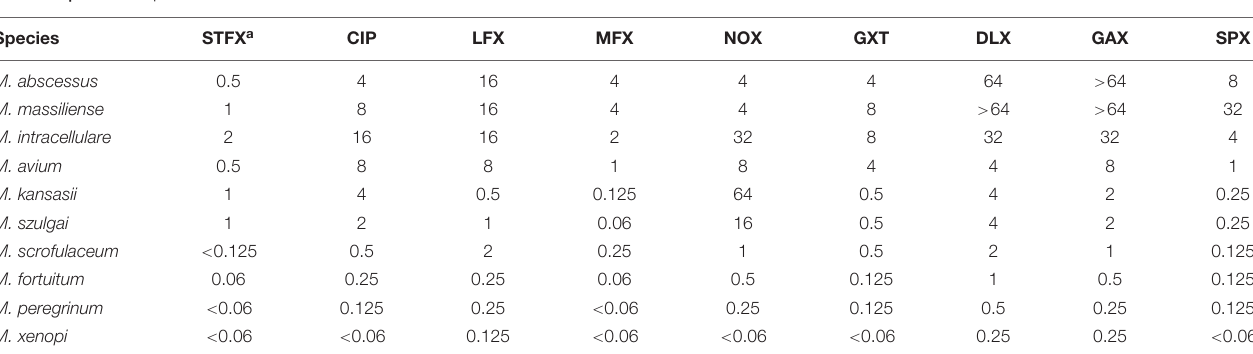
TABLE 3 | MIC of 9 quinolones for NTM reference